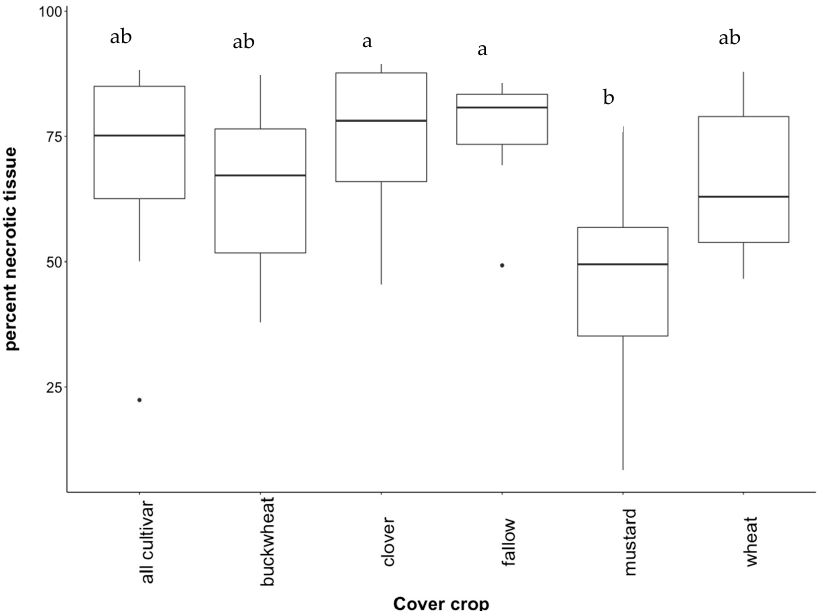
Figure 1. Percent necrotic tissue of grapevines growing in soil conditioned by cultivar cover crops. Treatments include a mixture of all plants (“all cultivar”), buckwheat (“buckwheat”), crimson clover (“clover”), uninoculated fallow (“fallow”), white mustard (“mustard”), and wheatgrass (“wheat”). Boxplots show the first and third quartile, median (middle line), range (whiskers), and circles (outliers). Letters represent statistical significance at p < 0.05. This section may be divided by subheadings and should provide a concise and precise depiction of the experimental results, their interpretation, and the experimental conclusions that can be drawn.